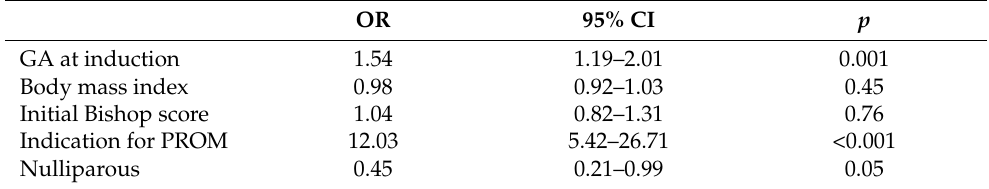
Table 4. Multivariable analysis of factors associated with good response (taking fewer than six tablets before labor) to the protocol.